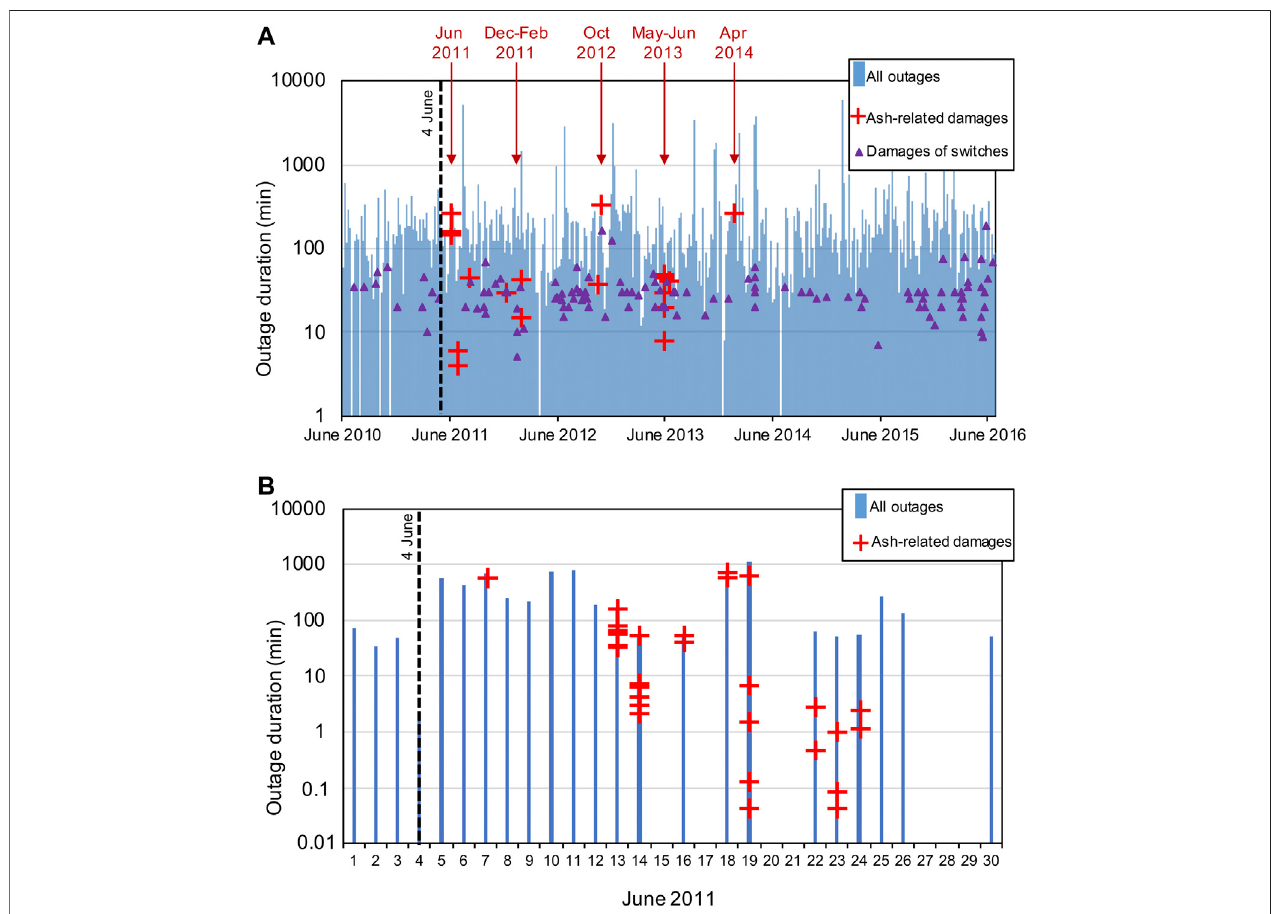
FIGURE6| Poweroutagesrecordfor (A) IJfrom2010to2016(courtesy:CompanyofElectricityofRíoNegro – EDERSA),andfor (B) SCBforJune2011(courtesy: Cooperative of Electricity of Bariloche). Dashed black lines indicate the beginning of the CC eruption. Blue bars correspond to all the damages reported from which: red crossescorrespondtodamagesunambiguouslyreportedasrelatedtoash,andpurpletrianglescorrespondtodamagesrelatedtoswitches.However,accordingtothe interviews, most of the switches damages are likely to be associated with ash.